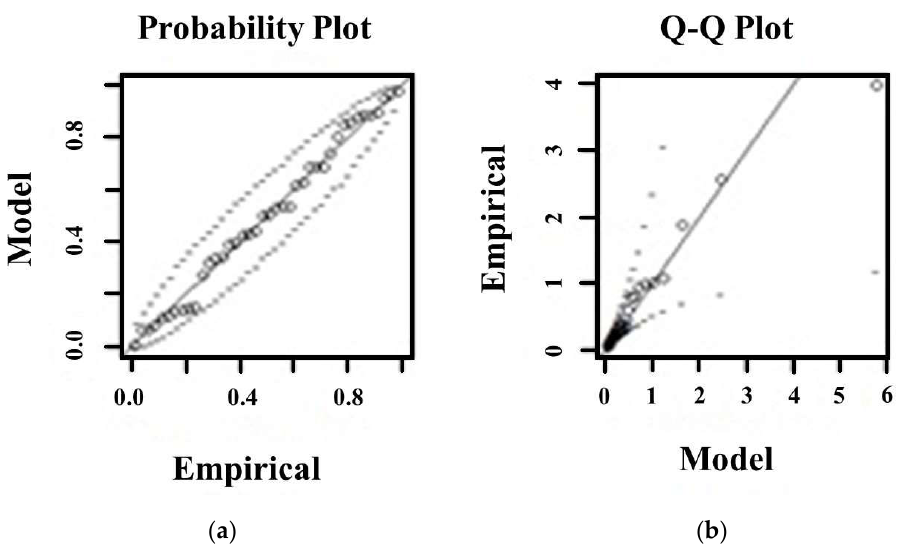
Figure 5. Example of the goodness of fit test of ( a ) Probability Plot and ( b ) Q-Q Plot with the 95% confidence interval (dashed lines) in Pápa between 1991–2016 to prove the goodness of the chosen threshold. The distribution of wet snow mass data [kg·m −1 ] above the threshold follow the Pareto distribution.